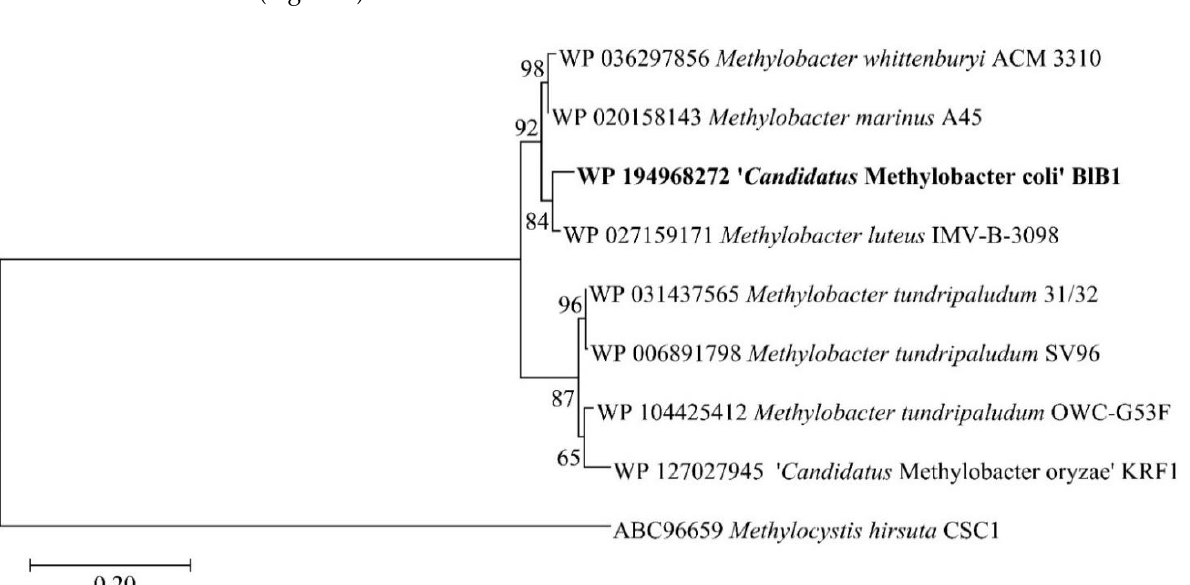
Figure 3. Maximum likelihood bootstrap tree of the pMMO B subunit protein sequences of strain BlB1 in comparison with the protein from type strains of valid species. The evolutionary history was completed using the maximum likelihood method based on the Poisson correction model and 1000 bootstraps. The bar represents 2% divergence. The phylogenetic tree was constructed using MEGA X.